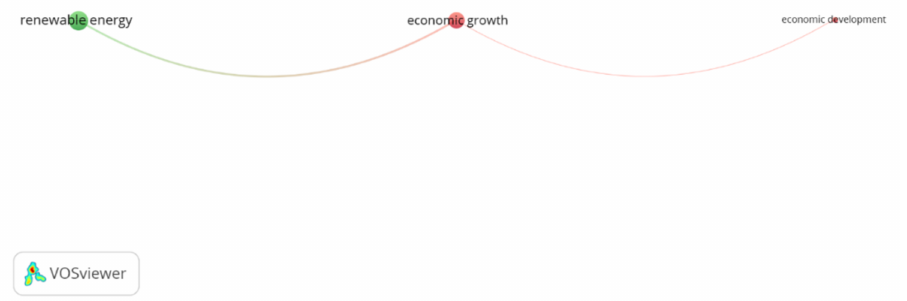
Figure 7. Link Between Renewable Energy, Economic Growth and Economic